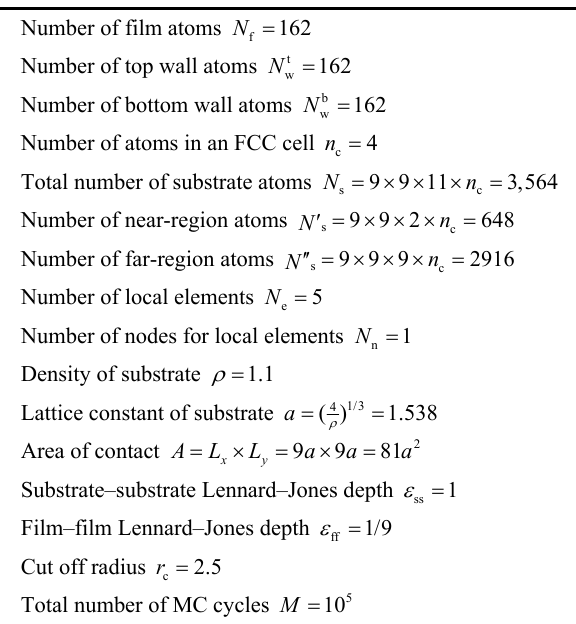
Table 1 Parameters of the fully atomic and multi-scale simulations of the thin-film lubrication.